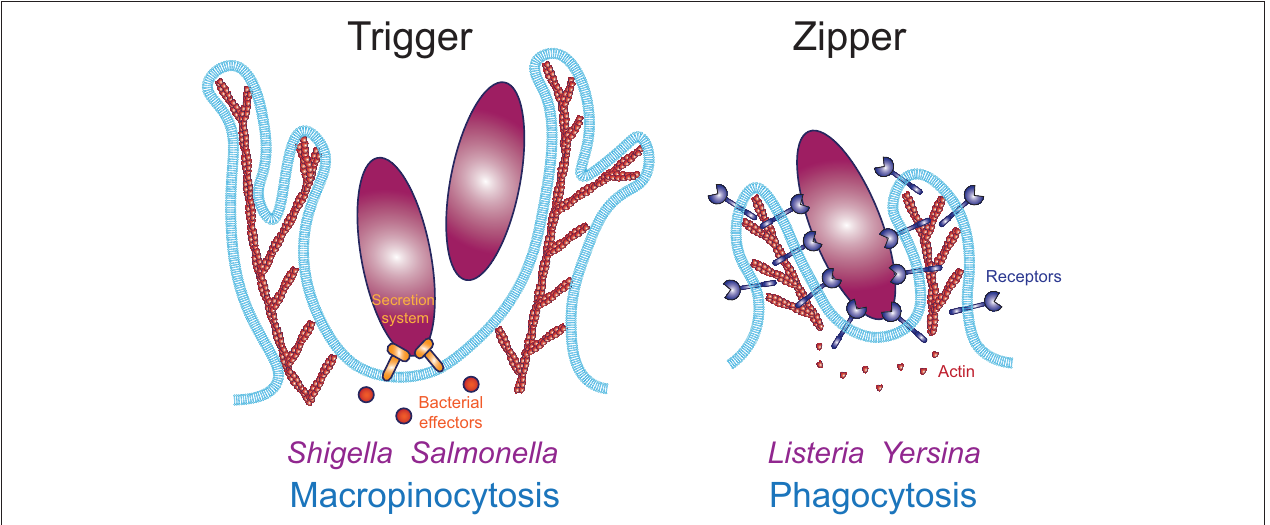
FIGURE 1 | Actin-based internalization mechanisms of large particulate materials. The trigger mechanism (Left) enables internalization in an adhesion-independent manner. Macropinocytosis is a trigger mechanism typically induced by growth factors, such as MCSF or EGF. Bacterial pathogens like Shigella and Salmonella induce their internalization via a trigger mechanism using a type III secretion system to inject effectors inside the host cell, which induce actin polymerization to induce local ruffle formation which surround and engulf the bacteria. Numerous viruses also enter their host cell through macropinocytosis. The zipper mechanism (Right) requires adhesion to host cell receptors along the entire surface of the particle. Converging evidence demonstrates that phagocytosis occurs through a zipper mechanism.